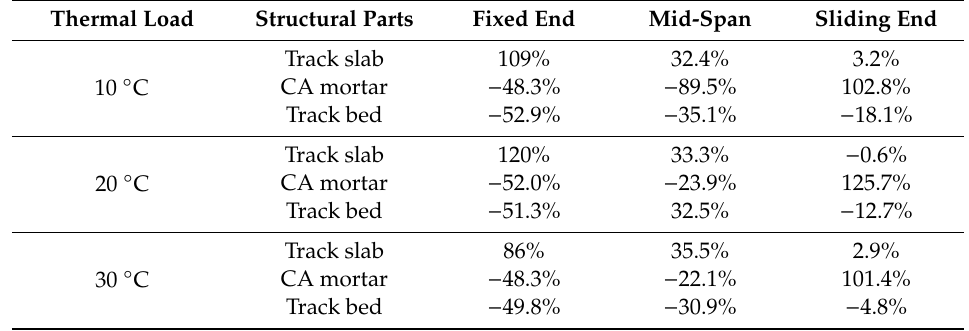
Table 2. Strain variation of the track structure between the states before and after repeated thermal test. Thermal